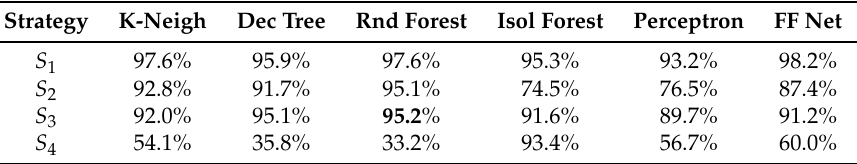
Table 2. The best accuracy values for different classification algorithms.